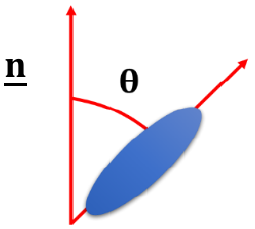
Figure 1. Schematic showing the angle θ between the director, 𝐧 and the long axis of a molecule.